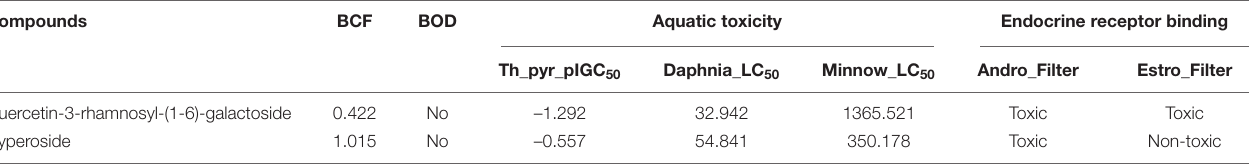
TABLE 3 | Results of the compound ecotoxicity.